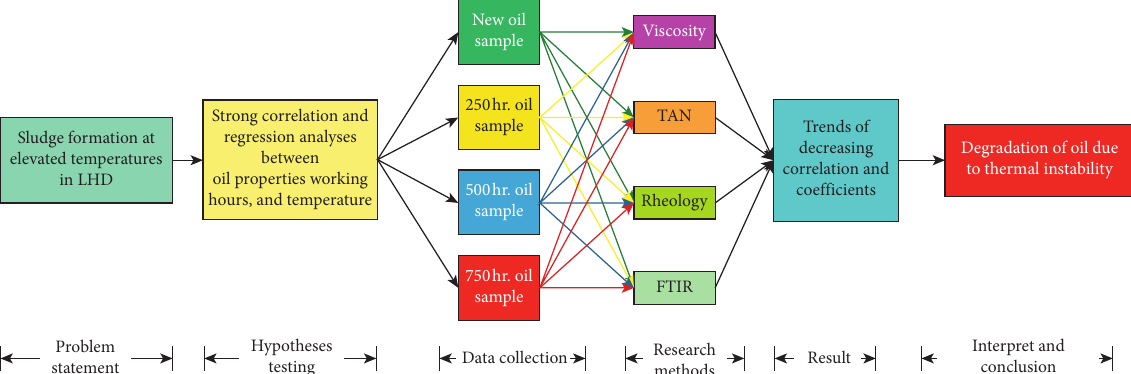
Figure 3: Block diagram of research methodology.